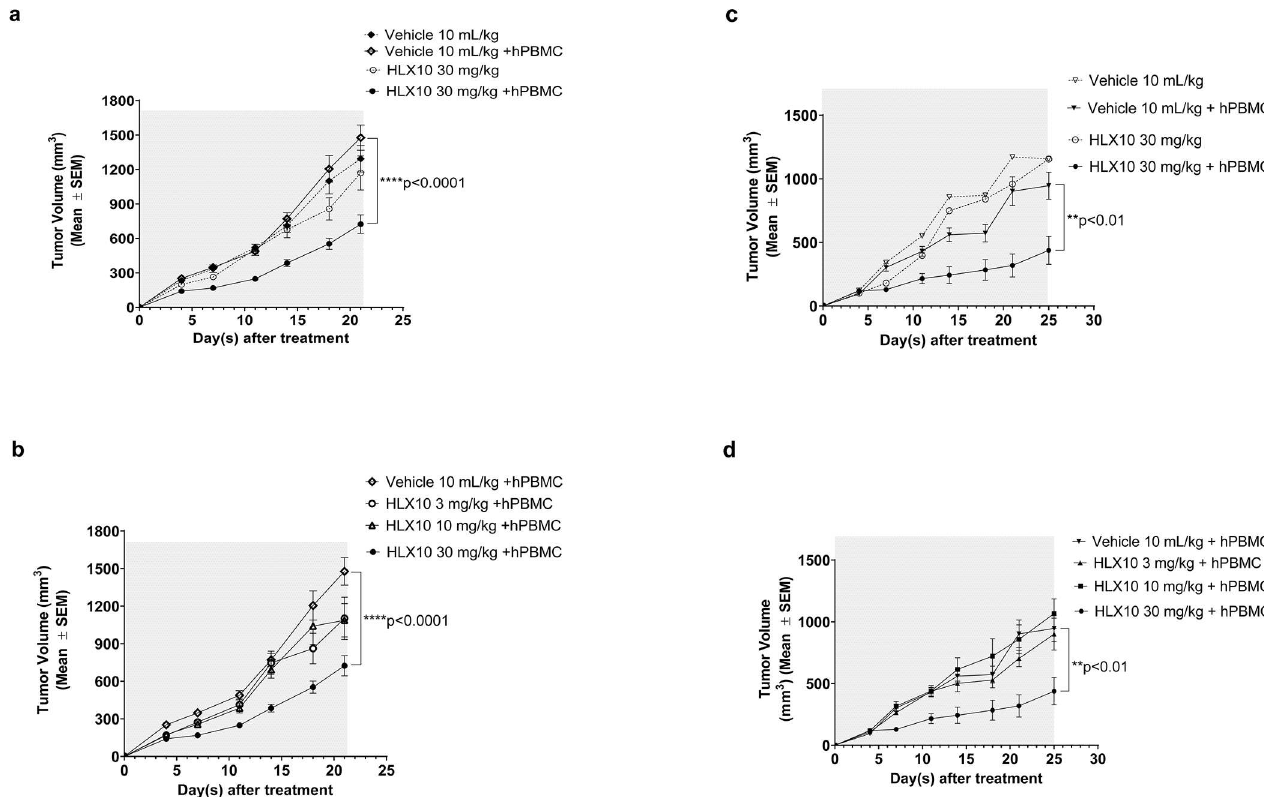
Fig 5. Tumor growth inhibition of HLX10 in HT-29- and NCI-H292 -hPBMC co-mixture xenograft mice models. The mice (n = 4/group) were engrafted subcutaneously with the mixture of human colon cancer cell lines HT29 (a, b), NCI-H292 (c, d), and freshly isolated human PBMC (cancer cells: PBMC = 2:1 and PBMC = 3:1, respectively). HLX10 (3, 10 and 30 mg/kg) antibody and vehicles were intraperitoneally injected into mice twice a week from day 1 as indicated (gray area). As controls, tumor cells only and HLX10 without hPBMC (30 mg/kg) were included. TGI are represented as the means ± SEM.